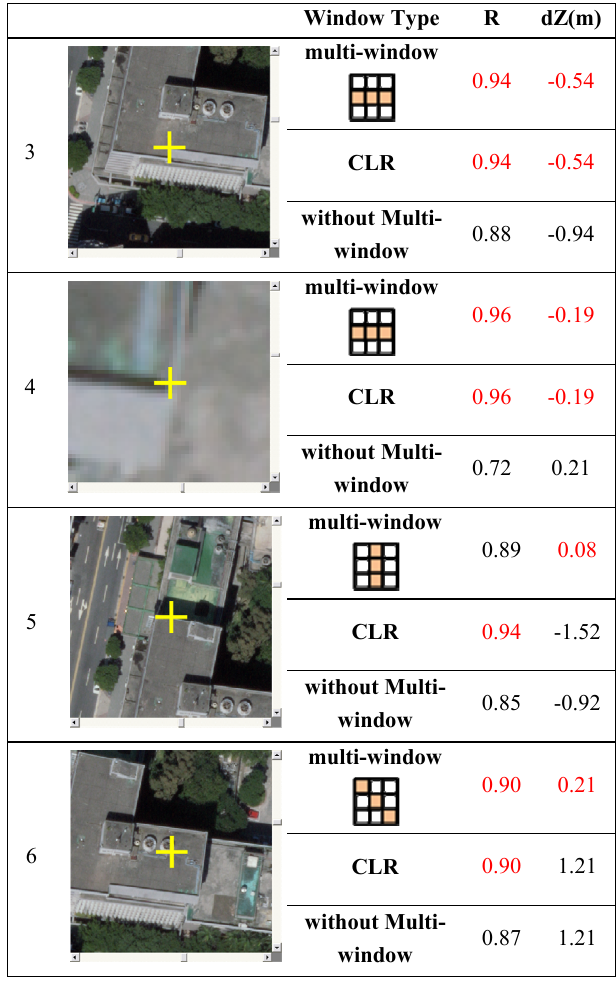
Table 5. Results of Object-based Matching in P3 ~